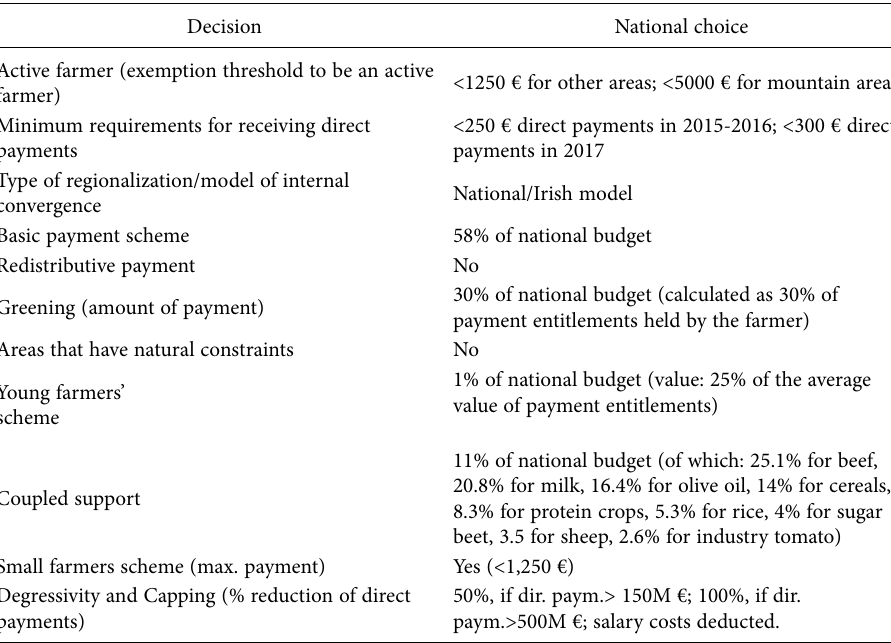
Table 3. Italian choices on direct